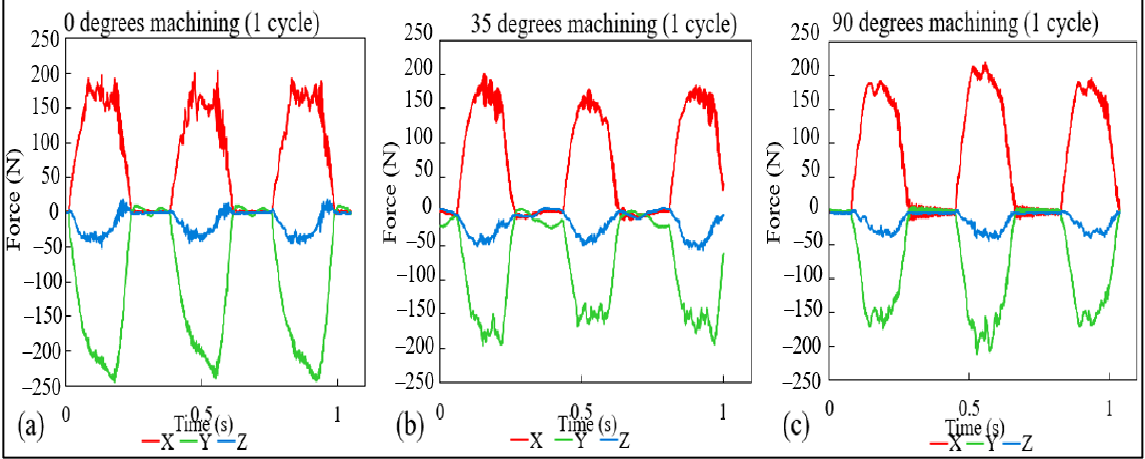
Figure 9. Cutting force measurement for one cutting cycle ( a ) 0 degrees, ( b ) 35 degrees, and ( c ) 90 degrees of cutting angle .